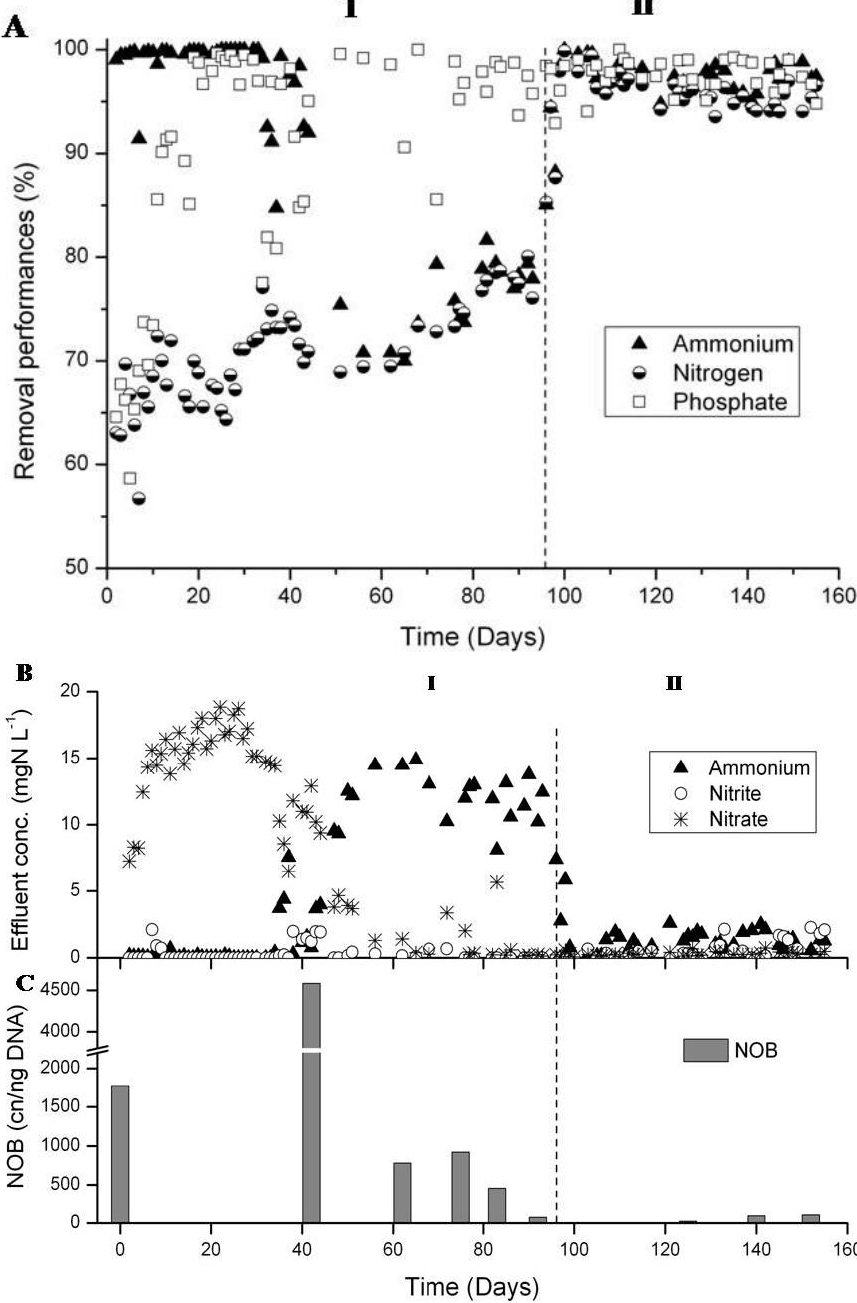
Figure 3. Nutrient removal performances of parent reactor between days 1 and 155. ( A ) Nutrient removal performances. ( B ) Concentrations of N compounds in the effluent and ( C ) Nitrospira 16S rRNA gene concentrations measured by qPCR. At day 96 (start of Phase II), the oxygen supply was increased, but automatically stopped upon completion of ammonium